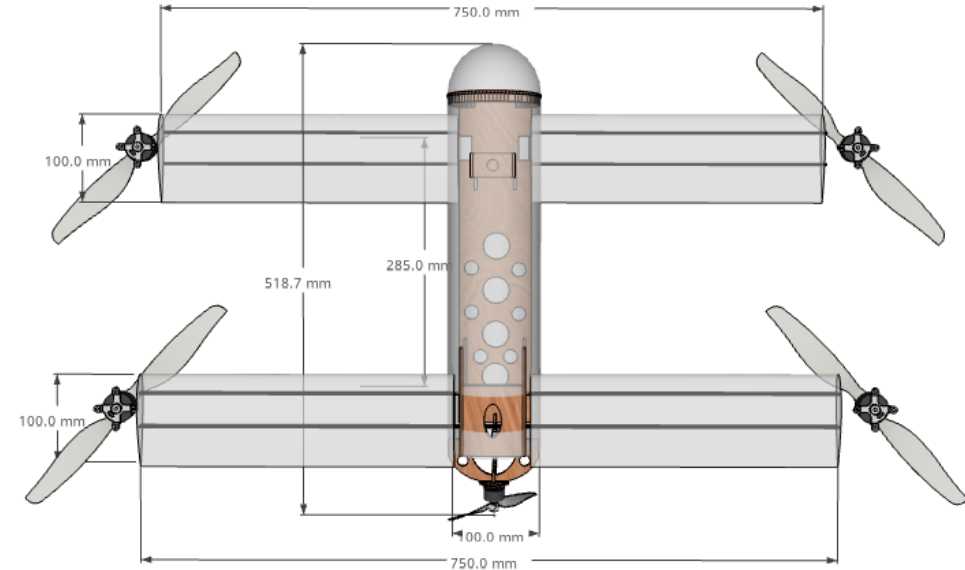
Figure 8. An overview of the Elka1Q drone dimensions—top